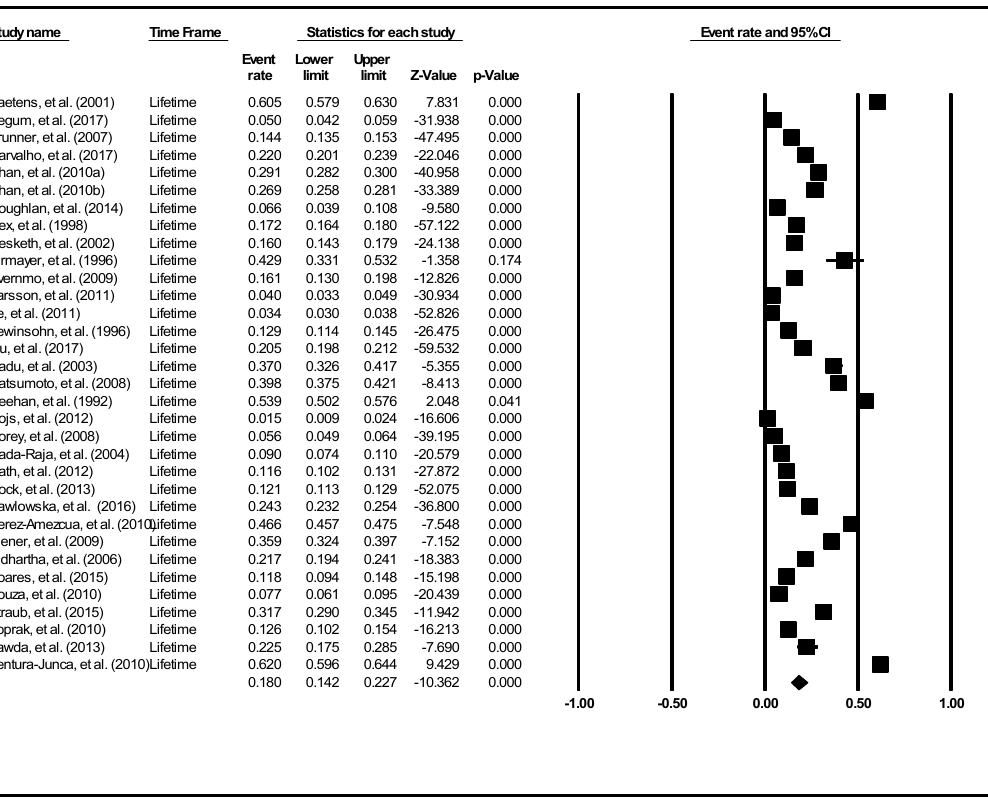
Figure 5. Forest plot of the lifetime aggregate prevalence of suicidal ideation.